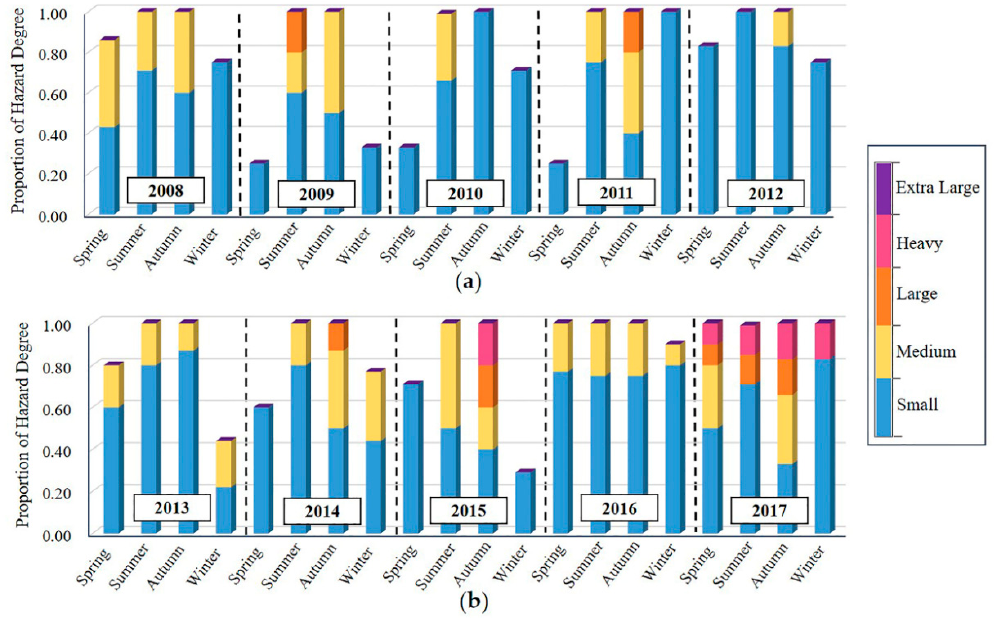
Figure 9. Proportion of the seasonal algal bloom coverage area of different hazard degrees in Taihu Lake. ( a ) Proportion of the seasonal algal bloom coverage area of different hazard degrees from 2008 to 2012. ( b ) Proportion of the seasonal algal bloom coverage area of different hazard degrees from 2013 to 2017.